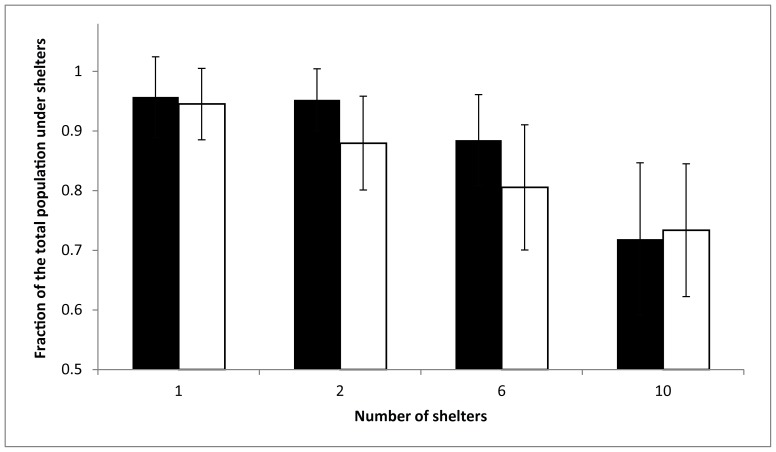
Theoretical and experimental influence of fragmentation on the sheltering behavior.Mean fraction of the total population under shelters (± S.D.) at t = 480 minutes for F1, F2, F6, and F10. Comparison of the experimental (black) and theoretical (white) data. Parameters values: μ = 0.0007, θ = 0.0049, n = 2.5, k = 4, ρ = 1296.